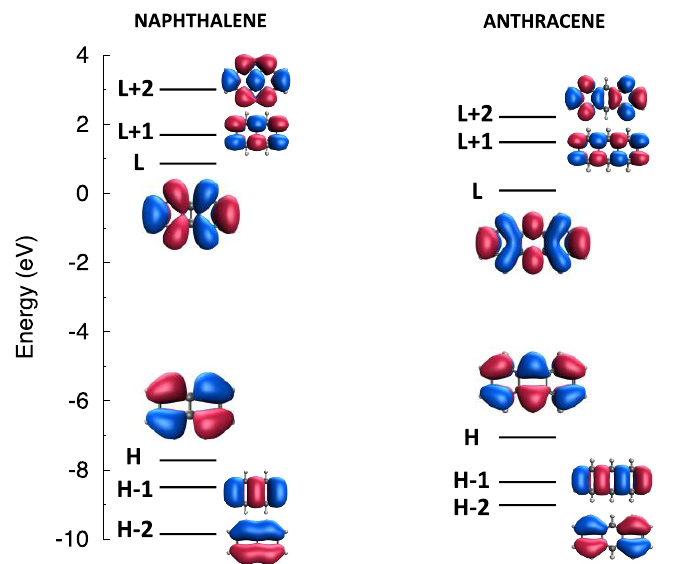
Figure 2. Frontier molecular orbital levels and shapes of (left) naphthalene and (right) anthracene, from ωB97X -D/6-31G* calculations (HOMO and LUMO abbreviated as H and L ).